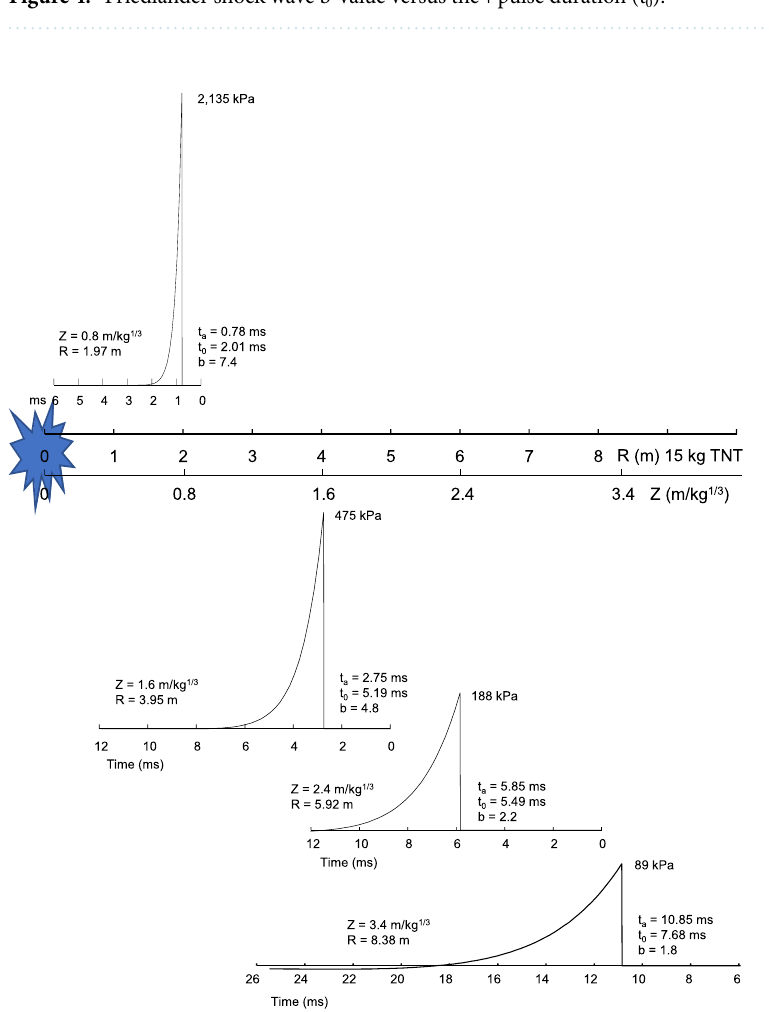
Figure 5. Shock wave characteristics versus time after arrival (t a ) with stand-off